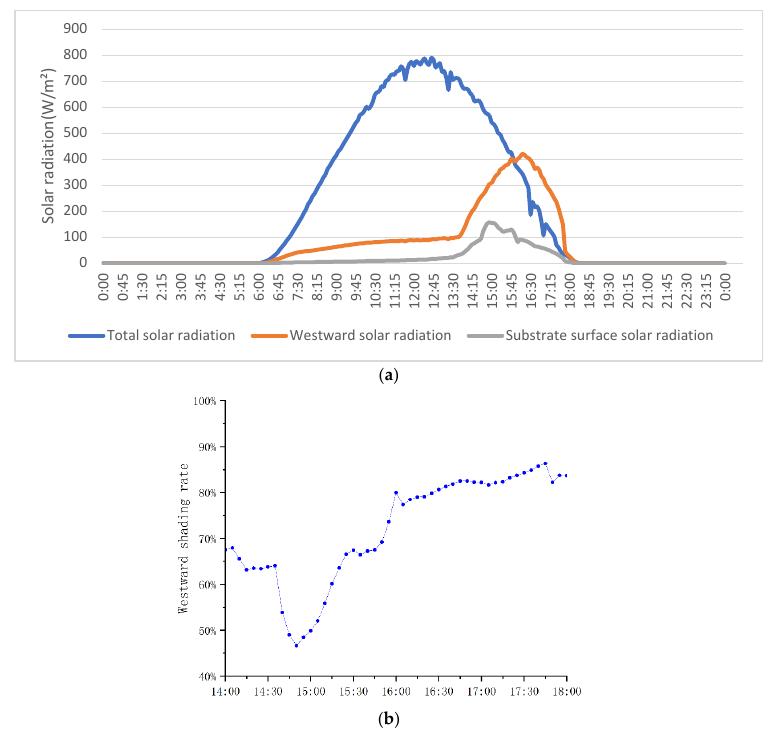
Figure 12. Solar radiation variation ( a ) and Shading rate of MVGSD ( b ).